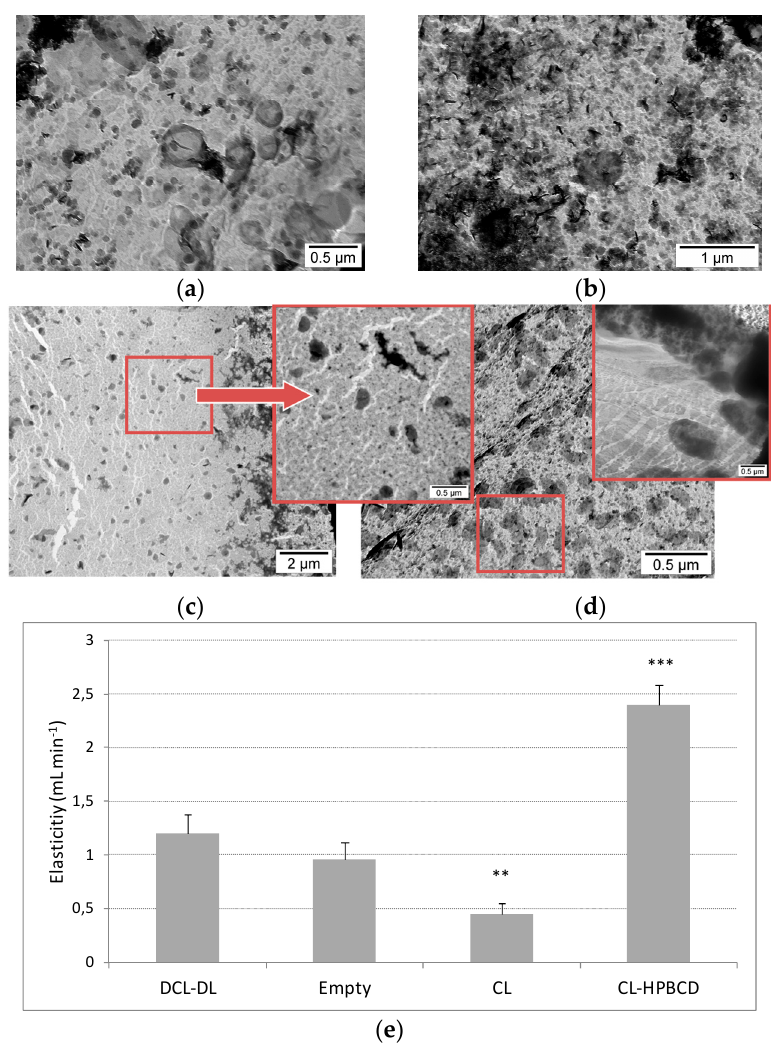
Figure 9. TEM images of liposomes: ( a ) and ( b ) Conventional liposomes (CL) containing buffer solution. In ( b ), it is possible to see many crystals, which is probably due to Cur precipitates. ( c ) Conventional liposomes containing 2-hydroxypropyl- α / β / γ -CD (HPBCD) in the buffer solution (CL–HPBCD). ( d ) Cur-in-cyclodextrin-in-liposomes double-loading (DCL–DL). ( e ) Elasticity of the vesicle formulations studied. Empty refers to CL without Cur. DI: deformability index. Values are means with standard deviation error represented by vertical bars. The mean value was significantly different compared with empty liposomes (** p < 0.01, *** p < 0.001; Student t test).